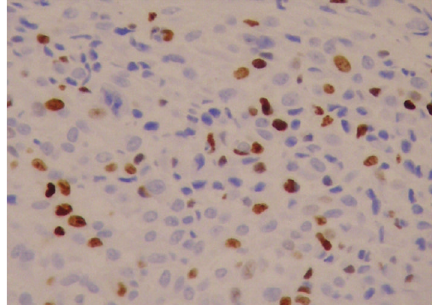
Figure2:Thetumornoduleswithhistiocyte-likeandosteoclast-like giant cellsand fibroblastsat theperiphery (hematoxylin-eosin, ×40 ).